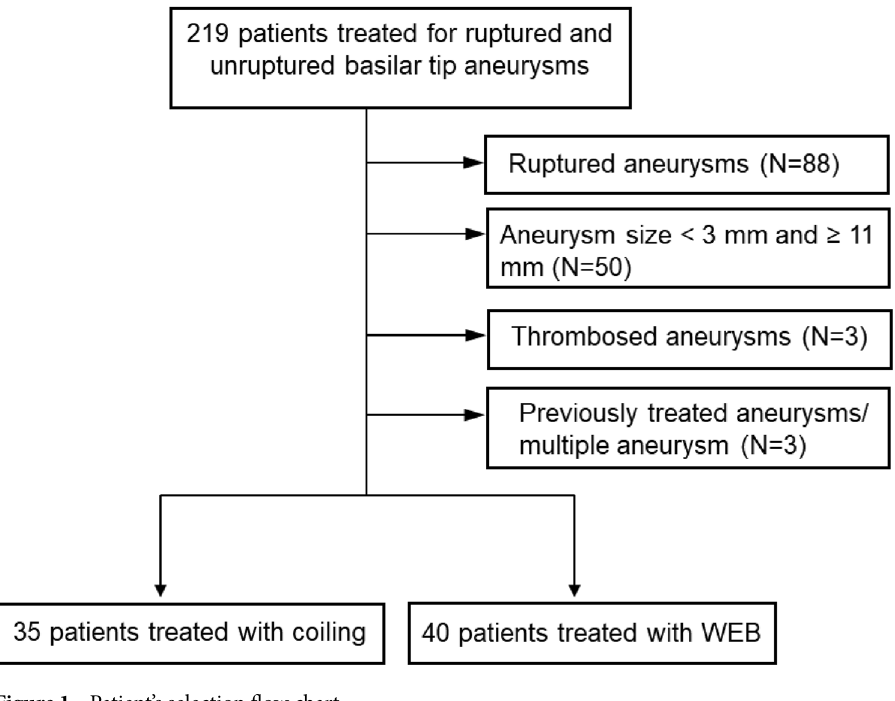
Figure 1. Patient’s selection flow